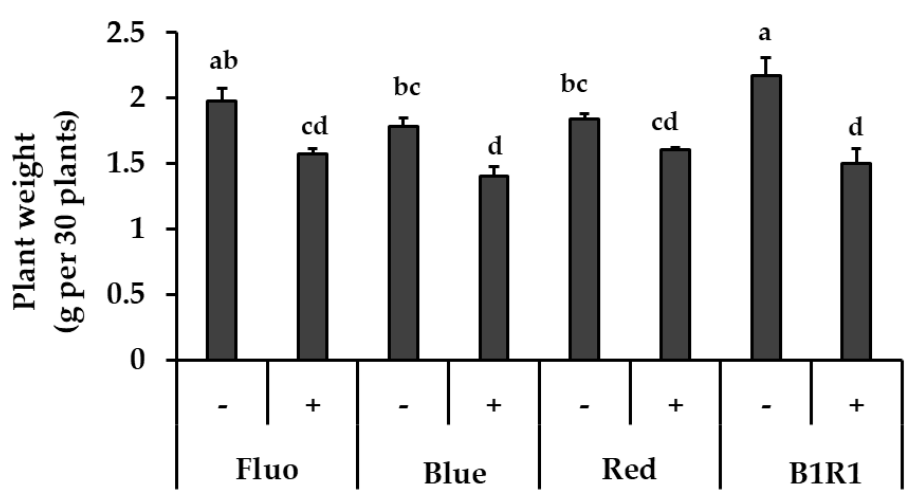
Figure 1. The effect of light, fluorescent (FL), blue, red, B1R1 (combination of blue plus red) on the biomass of microgreens cultivated in the absence ( − ) and presence (+) of salt, one week after treatments ( n = 90). Data were expressed as mean ± standard error of three replicates. ANOVA analysis was done using Duncan’s method and different letters were used to show statistical significance ( p < 0.05).